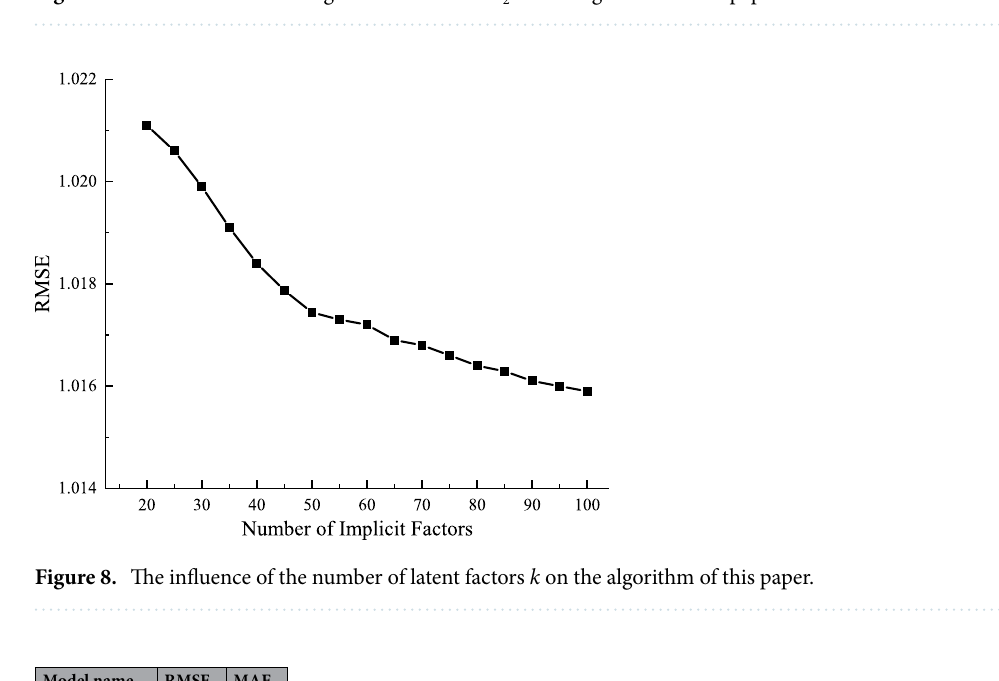
Figure 7. The influence of L2 regularization factor λ 2 on the algorithm of this paper.